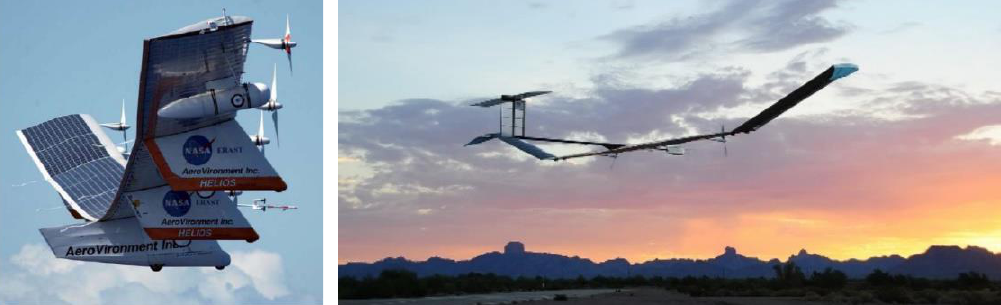
Figure 1. The flying-wing Helios developed by NASA ( left ) and the wing-tail Airbus Zephyr ( right ).